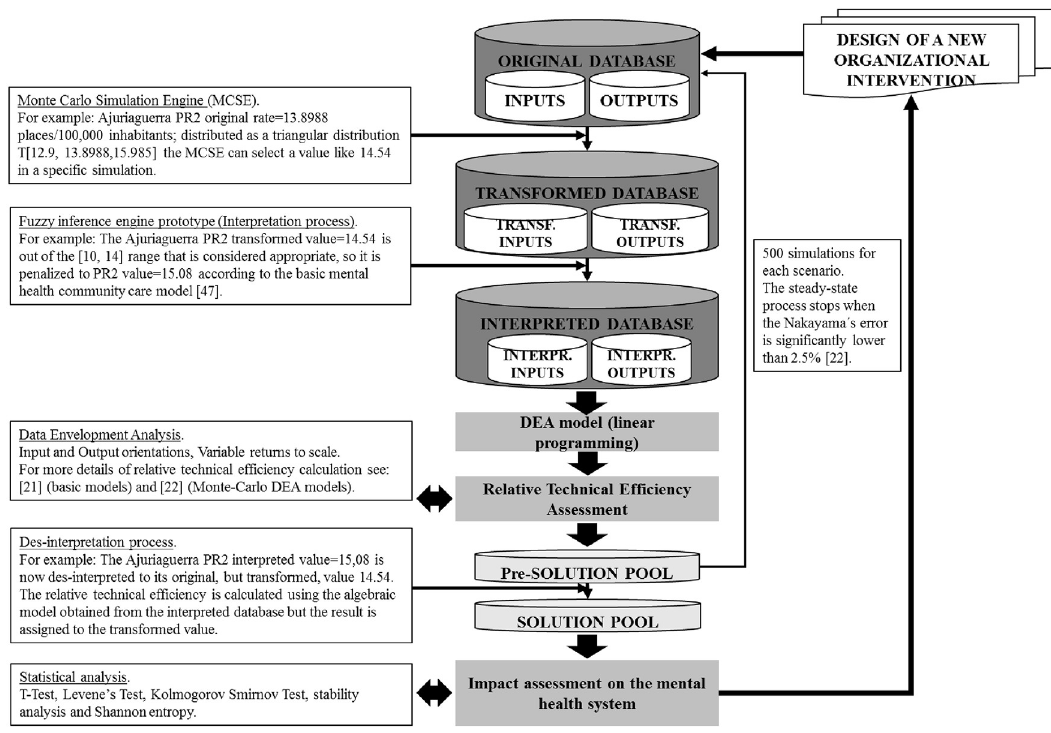
Fig 1. Analysis of an organizational intervention: A flowchart.